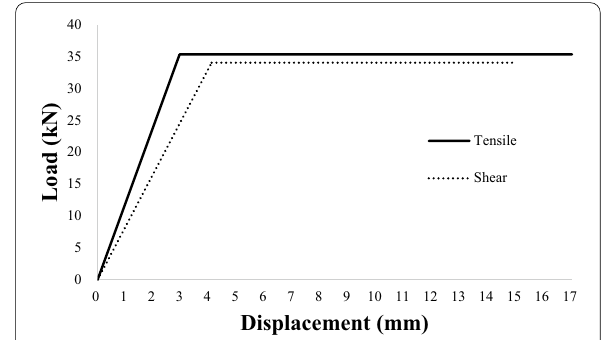
Fig. 12 Load–displacement curves of connectors